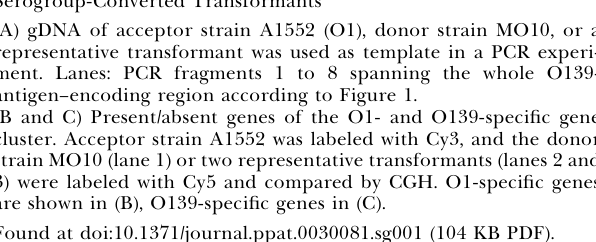
Figure S1. Phage-Mediated Selection Leads to Accumulation of Serogroup-Converted Transformants (A) gDNA of acceptor strain A1552 (O1), donor strain MO10, or a representative transformant was used as template in a PCR experi- ment. Lanes: PCR fragments 1 to 8 spanning the whole O139- antigen–encoding region according to Figure 1. (B and C) Present/absent genes of the O1- and O139-specific gene cluster. Acceptor strain A1552 was labeled with Cy3, and the donor strain MO10 (lane 1) or two representative transformants (lanes 2 and 3) were labeled with Cy5 and compared by CGH. O1-specific genes are shown in (B), O139-specific genes in